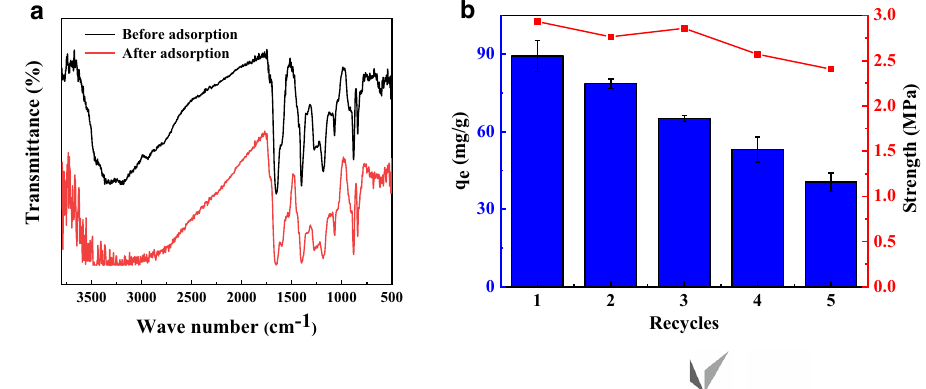
Fig. 10 a FTIR spectra of AOPAN/PVDF and after adsorption, b performance of the AOPAN/PVDF membrane (70 °C and 120 min) in five consecutive cycles of adsorption and